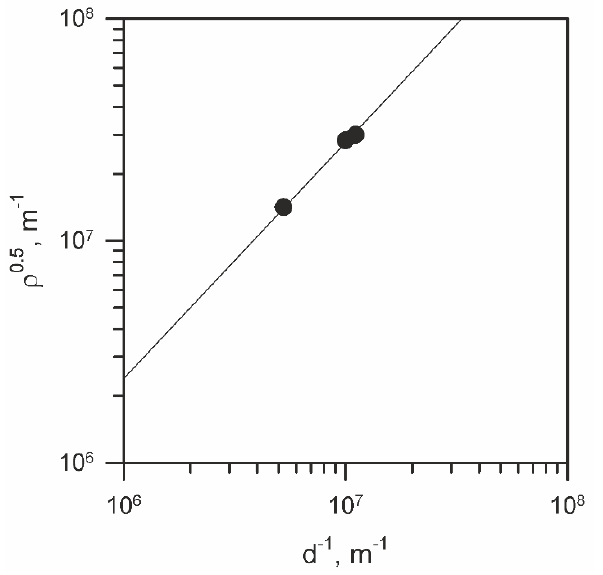
Figure 5. Relationship between the subgrain size (d) and the dislocation density inside subgrains ( ρ ) in an HSLA steel subjected to tempforming at different temperatures.